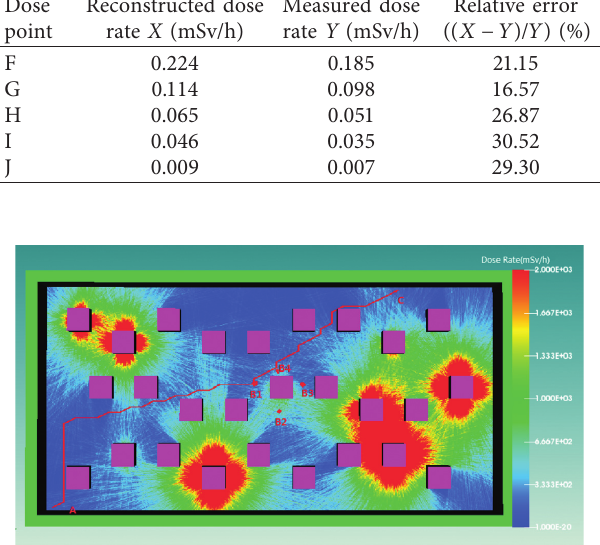
Figure 5: Schematic diagram of the optimized operation